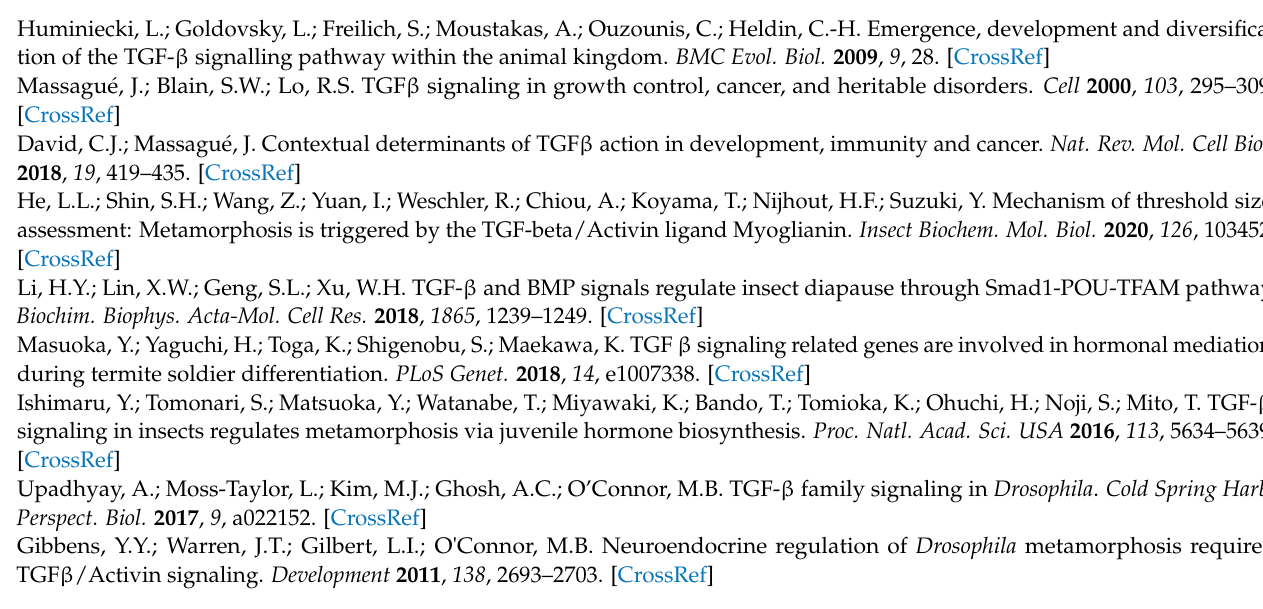
Figure S4: Effects of Sax RNAi on the expression of 20E biosynthesis genes; Figure S5: Effects of Sax RNAi on the expression of Sax and 20E pathway-related genes in abnormal parts of larvae and 1-day pupae. Figure S6: Effects of Sax RNAi on the expression of JH pathway genes; Table S1: Primers used for dsRNA synthesis and qRT-PCR analysis; Table S2: The accession numbers of protein sequences included in the phylogenetic